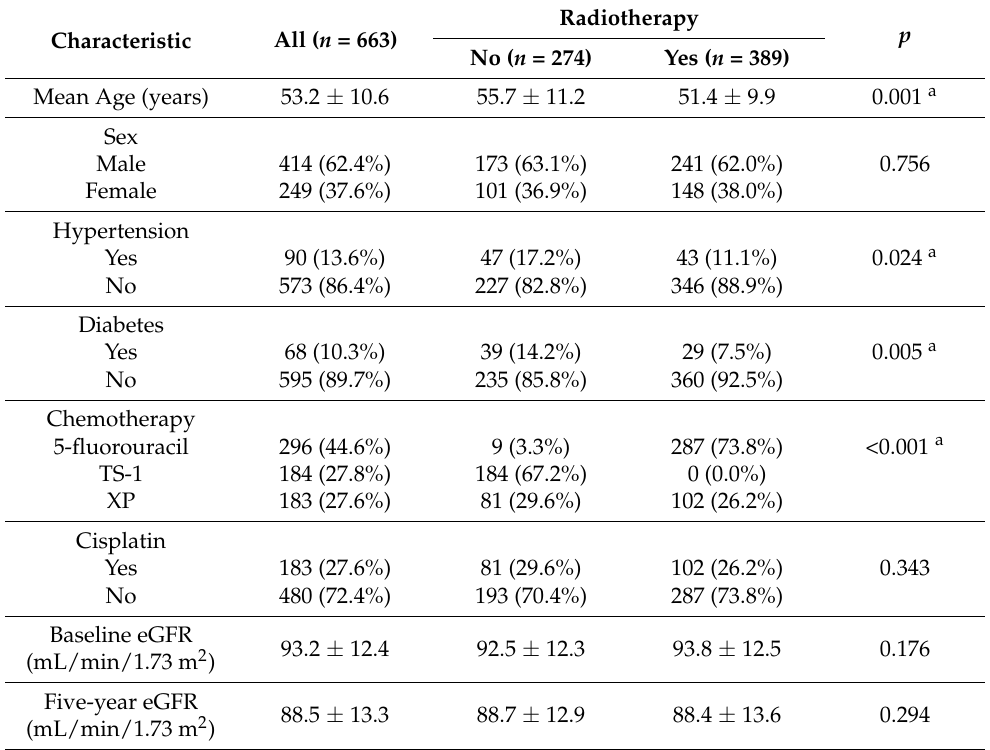
Figure 1. Histogram of baseline and five-year estimated glomerular filtration rates.